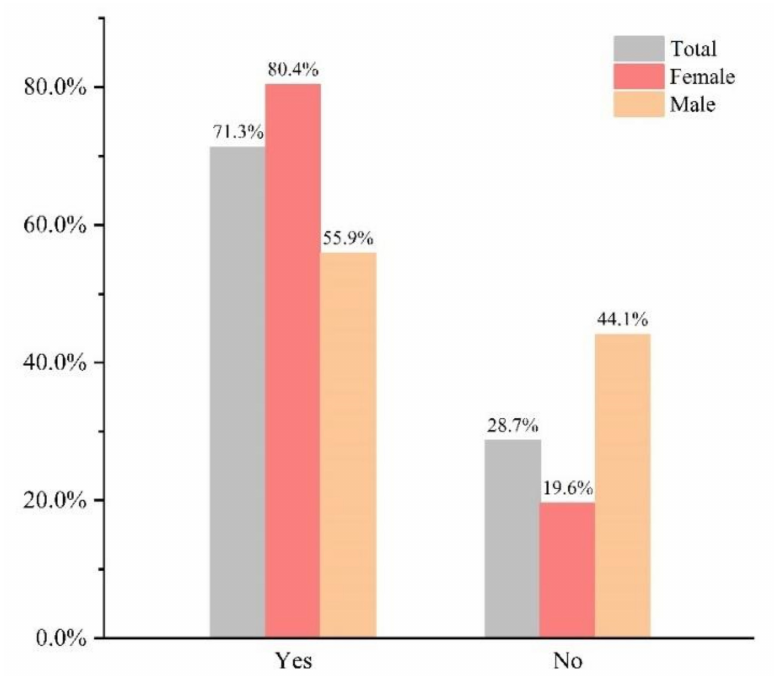
Figure 1. Willingness to vaccinate against HPV. Note: “Yes”: participants were willing to be vacci- nated against HPV; “No”: participants were unwilling to be vaccinated against